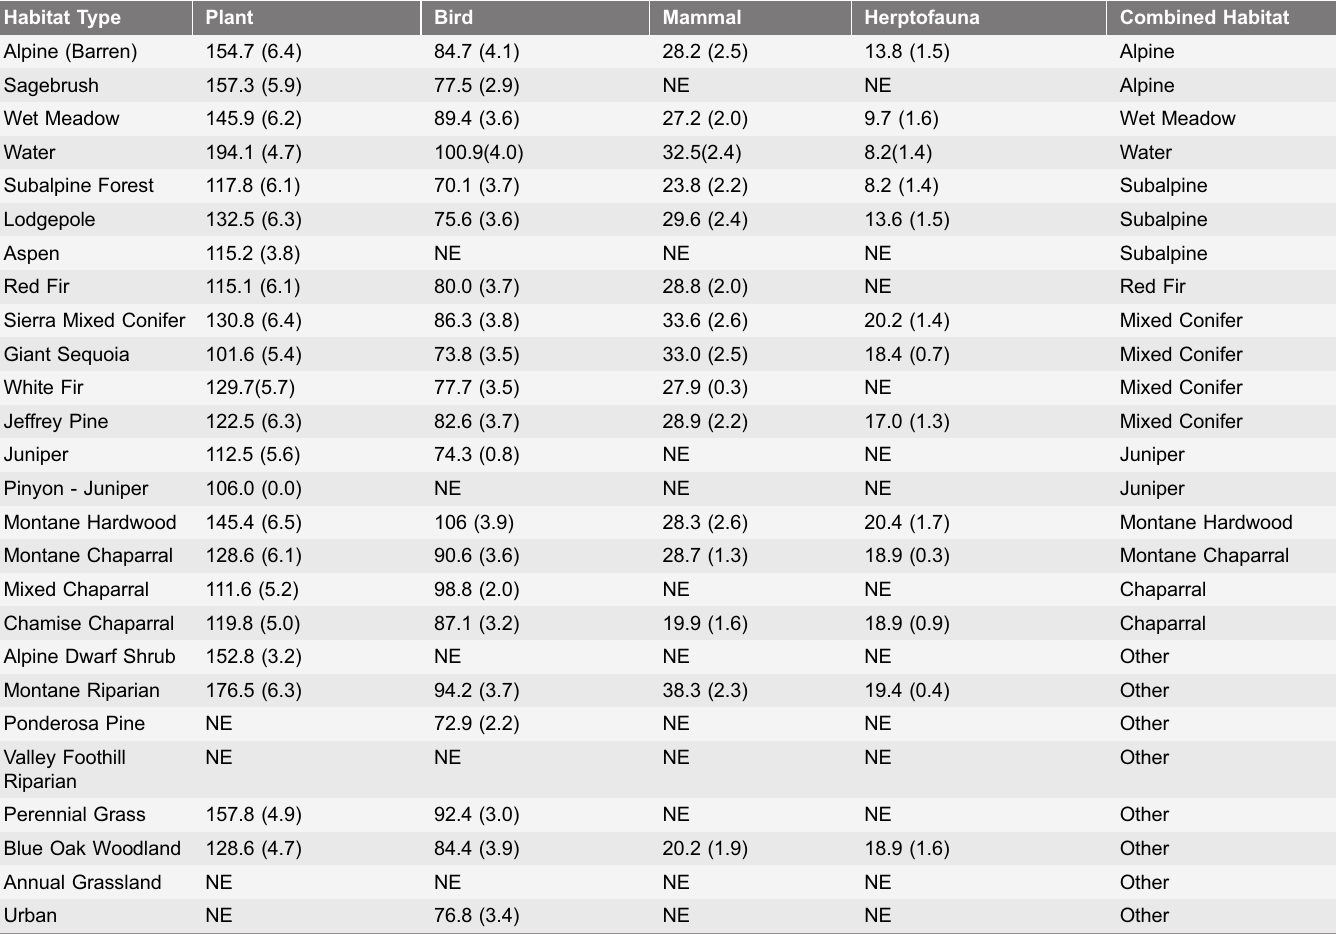
Table 2. Species richness values and (standard errors) for each of the four taxonomic groups by California wildlife habitat